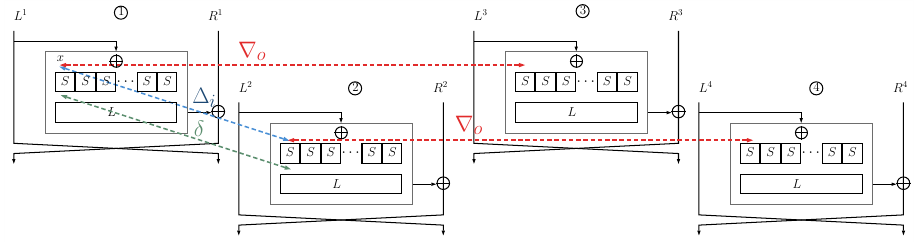
Figure 6: View of the parameters of the FBDT : ∆ i is the input difference and δ is the output difference of S when looking at the difference between state 1 (cid:13) and 2 (cid:13) . ∇ o is the input difference of the same Sbox S when looking at the difference between state 1 (cid:13) and 3 (cid:13) (which is the same as the one between state 2 (cid:13) and 4 (cid:13)